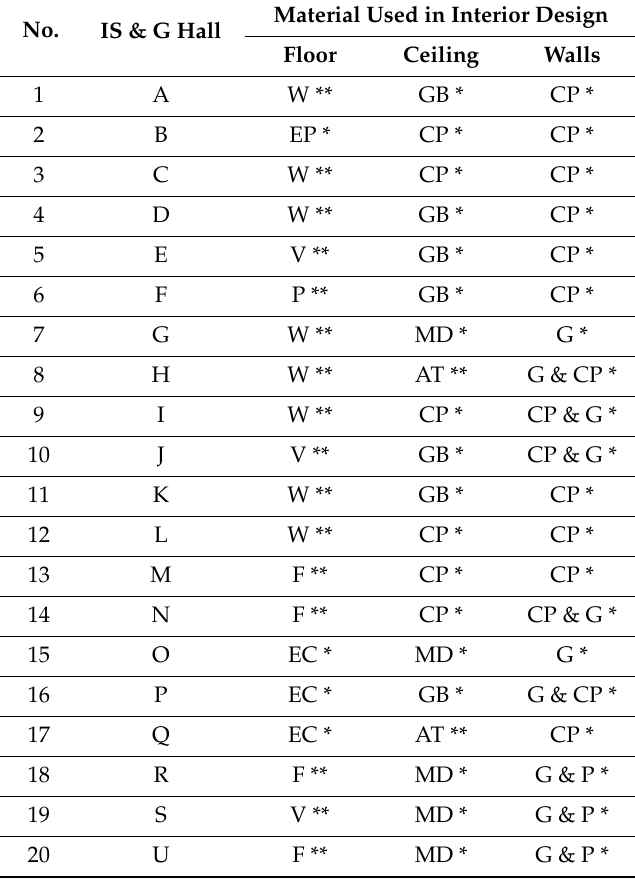
Table 1. Interior finishing materials used on the floors, ceilings, and walls in studied indoor sports and gymnasium (IS & G) halls. Material Used in Interior Design No. IS & G Hall Floor Ceiling Walls 1 A W ** GB * CP